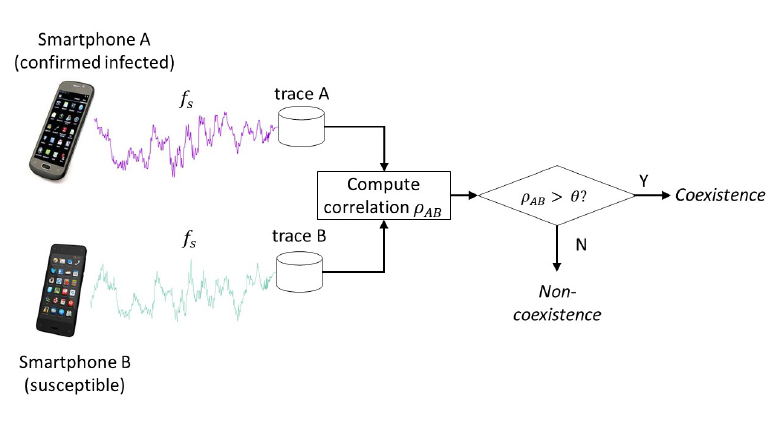
Figure 2. How the magnetometer traces could be used for contact